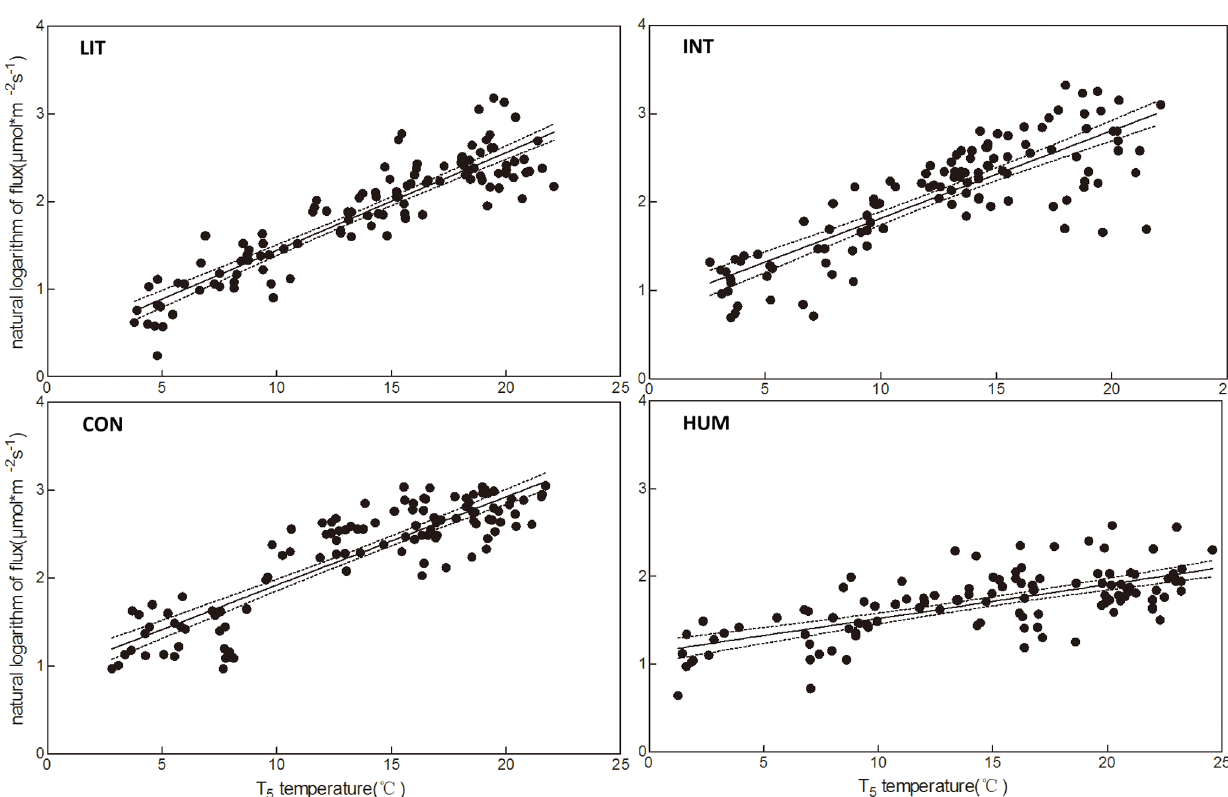
Fig. 5. Correlation between ecosystem respiration and T 5 each groundwater table treatment, as well as for plateau zokor treatment. A linear equation describing the correlation between the natural logarithm of the ecosystem respiration and the soil temperature and the 95% confidence interval are shown: site LIT ( y 5 0.11 x + 0.33, R 2 5 0.83, P , 0.001); site INT ( y 5 0.10 x + 0.83, R 2 5 0.68, P , 0.001); site CON ( y 5 0.10 x + 0.92, R 2 5 0.77, P , 0.001); site HUM ( y 5 0.04 x + 1.13, R 2 5 0.46, P , 0.001).